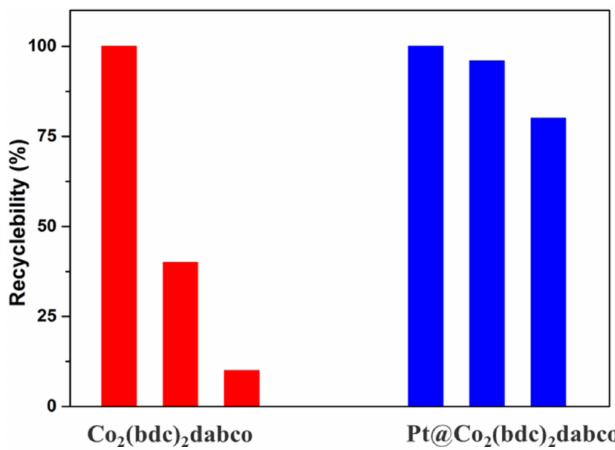
Figure 13. Recyclability test of Co/C and Pt@Co/C (10:1:2.4) relative to catalytic